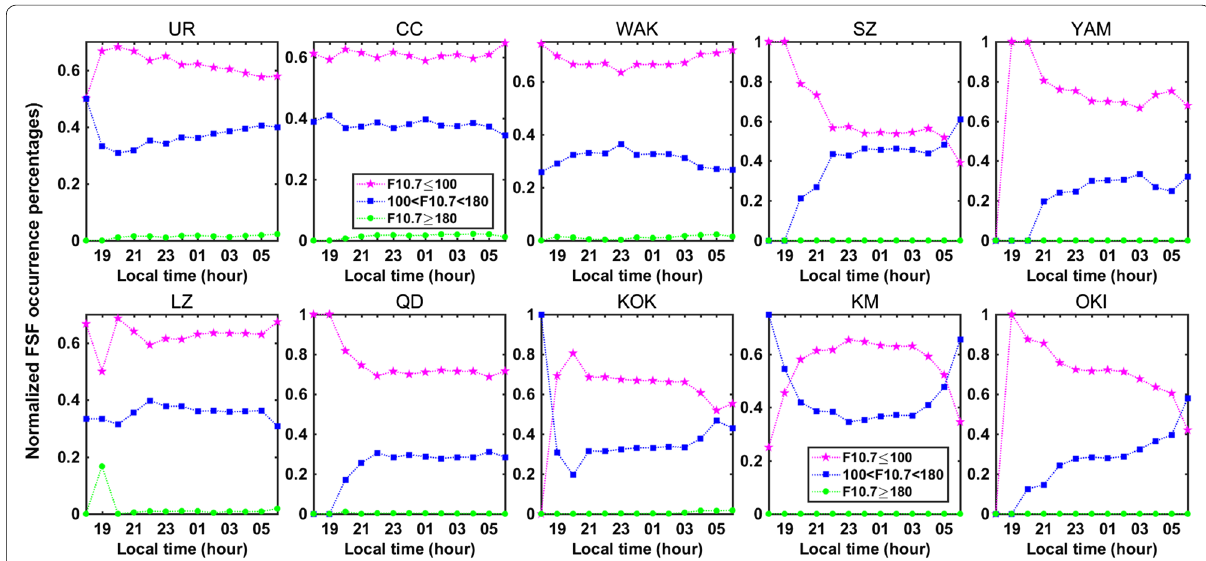
Fig. 4 Variations in normalized FSF occurrence percentages on different F10.7 index levels; magenta lines represent the high solar activity, blue lines represent the medium solar activity, and green lines represent the low solar activity